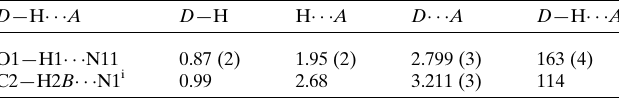
Table 4 Hydrogen-bond geometry (A˚ , (cid:5) ) for 2 .